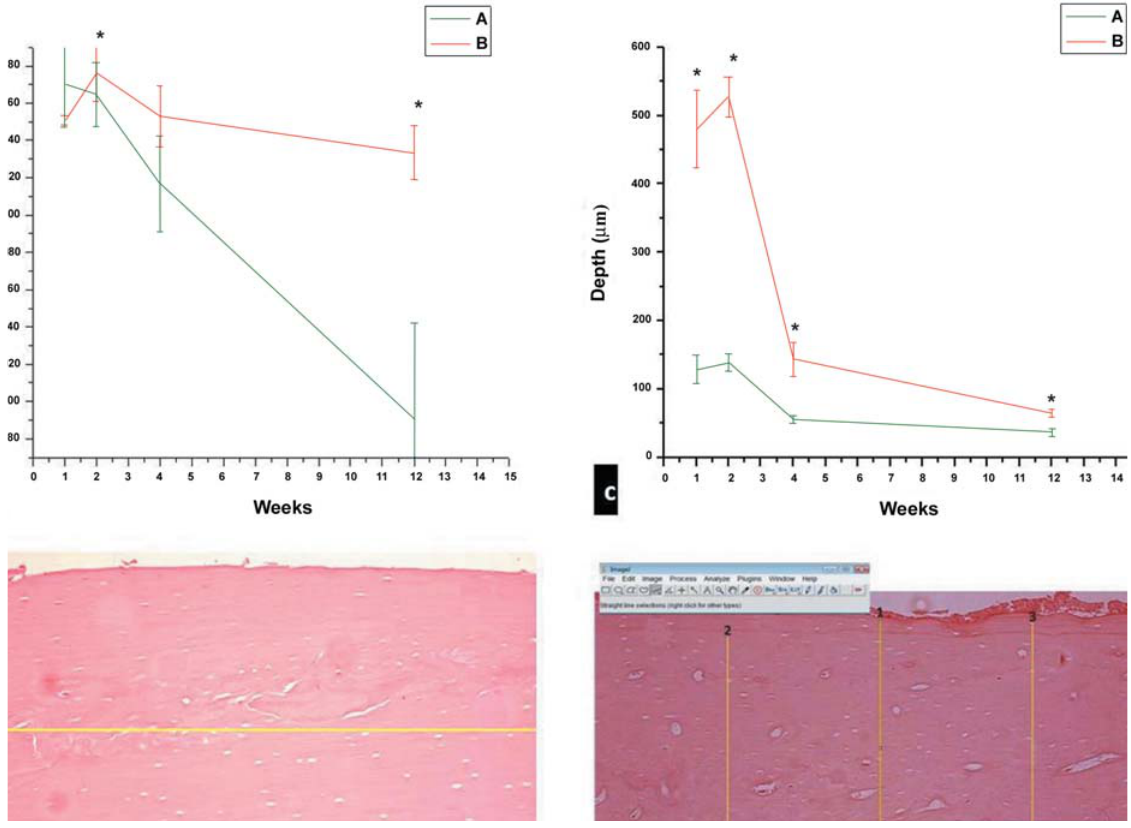
Figure 1- Comparison of the linear extent (a, b) and depth (c, d) of bone necrosis between the 1-min (A) and 2-min (B) cryosurgery protocols according to experimental week (mean±SD). *p<0.05 (comparison between protocols A and